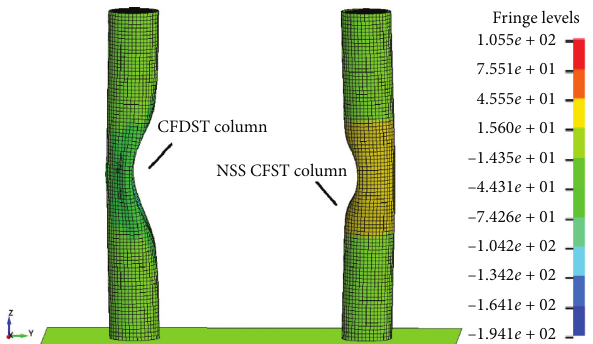
Figure 13: Side-by-side comparison of simulation results for two kinds of CFST columns (scaled distance � 0.14 m/kg 1/3 the top, middle, and bottom regions are summarized in Table 12. From the data in Table 12, the deformation dis- tribution of the surface facing the explosive was approxi- mately symmetric with respect to the blasting centre. The final deformation values of the NSS CFST column were less than those of the CFDST column. This shows that the NSS column was superior to the CFDST column in terms of the antiexplosion performance.